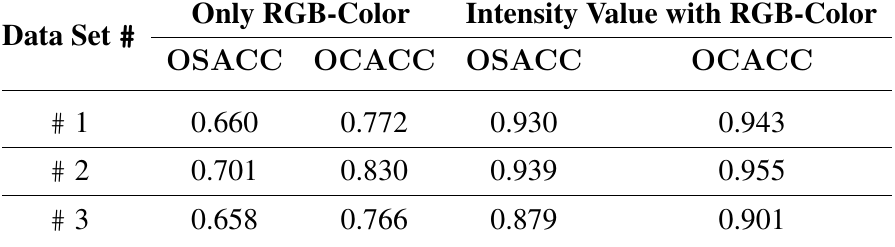
Table 9. Overall segmentation and classification accuracies when using RGB-Color and reflectance intensity